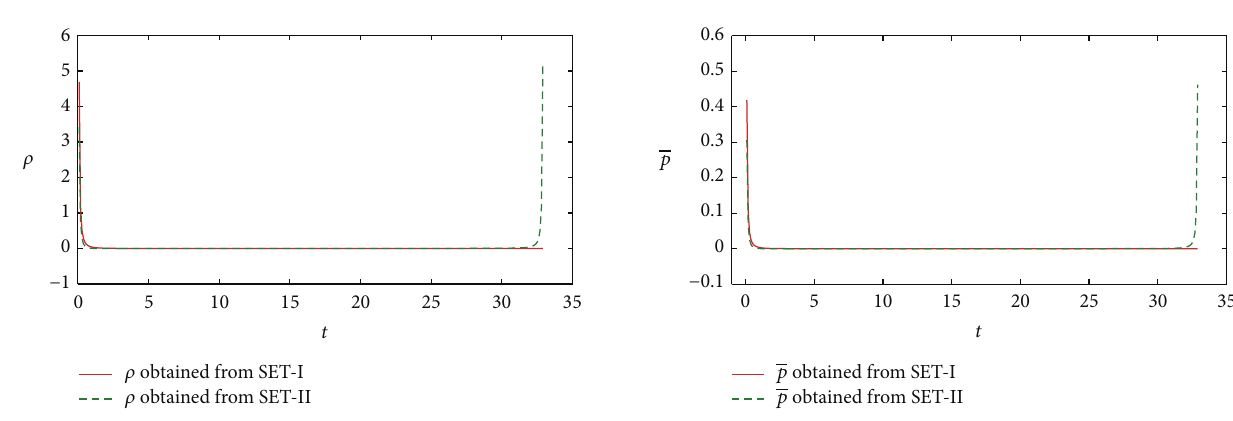
Figure 1: Density 𝜌 versus time 𝑡 for 𝜇 = 0 . 5, 𝜖 0 = 1 / 3, 𝛾 = 1, = 1, 𝑅 = 1, 𝑛 = 1 . 6, and 𝑘 = 0 . 097. 𝛽 = 1 . 5, 𝛼 = 0 . 1, 𝐴 1 1